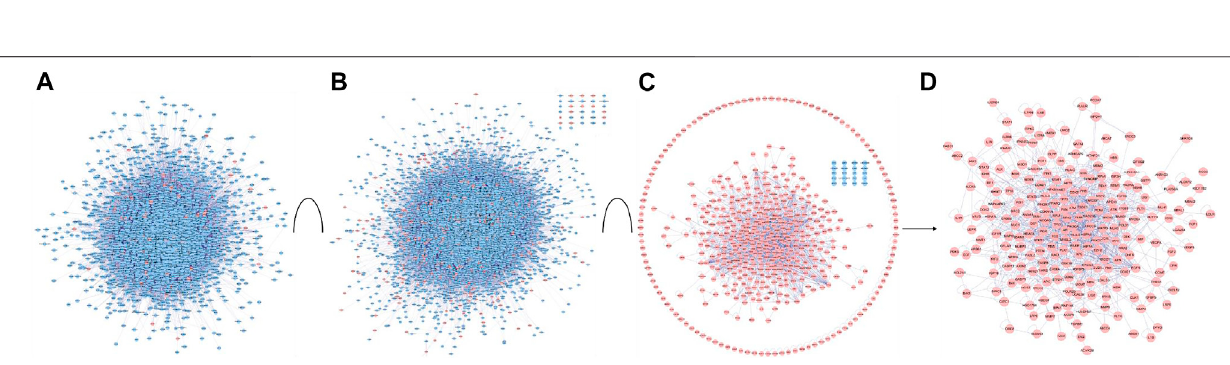
Frontiers in Pharmacology |